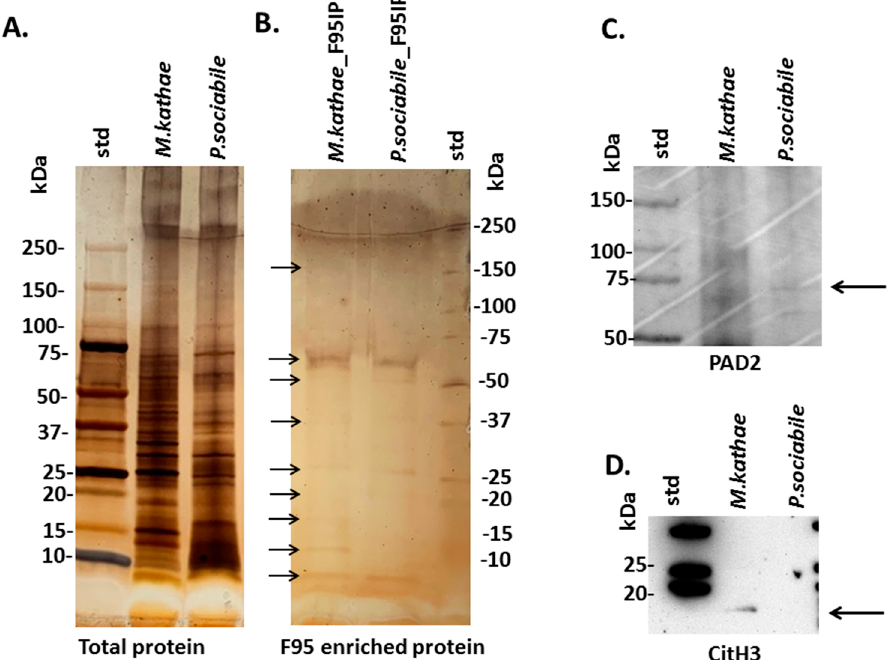
Figure 1. Alveolata PAD/ADI and deiminated protein identification. ( A , B ): silver stained SDS-PAGE gel (4–20% gradient TGX gel), showing total protein extraction ( A ) and F95-enriched fractions ( B ) from the two alveolate species (arrows point at F95 enriched protein bands observed, with some differences between the two species; the F95 eluate was further subjected to LC-MS/MS analysis for identification of deiminated protein candidates). ( C ). Western blotting analysis for PAD homologues in Alveolata, using the anti-human PAD2 antibody (see arrow for expected molecular weight size between 70–75 kDa, more clearly observed in P. sociabile than in M. kathae, where a smudged band between 50–100 kDa is observed). ( D ). CitH3 detection in both alveolates shows some positive reaction with M. kathae , but negligible with P. sociabile , possibly due to low protein load. The protein standard (std) is indicated in kilodaltons (kDa).